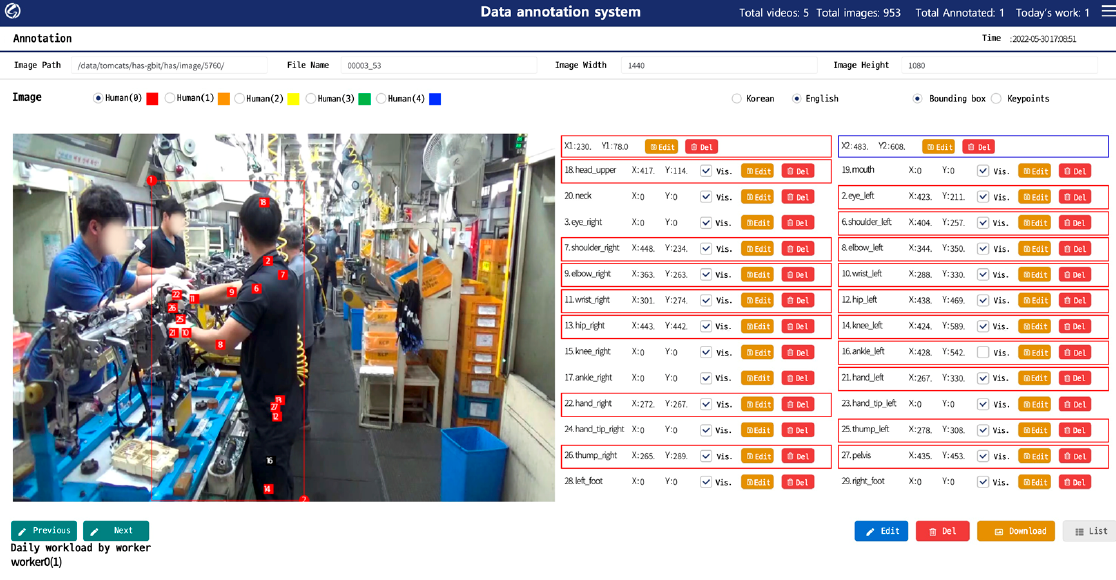
Figure 7. Graphic User Interface for creating annotated worker posture.